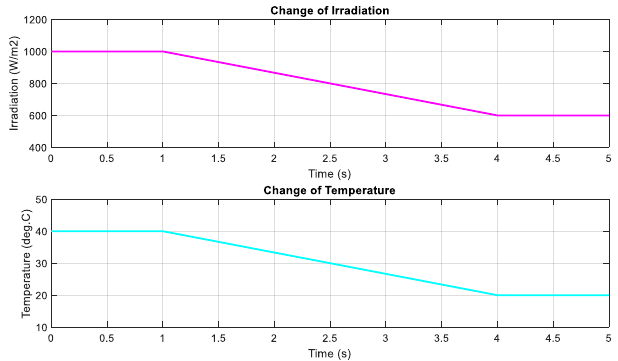
Figure 11. The change of both irradiation and temperature.